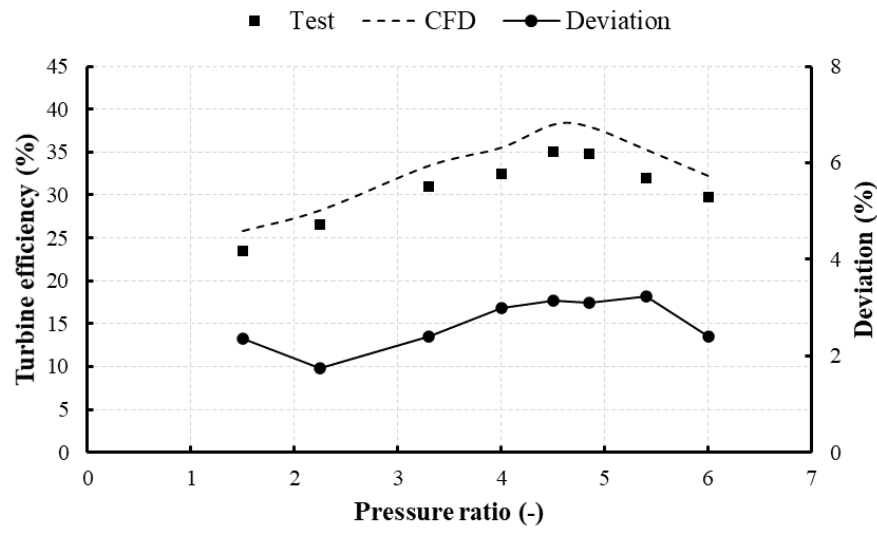
Figure 17. Comparison between numerical results and experimental results.